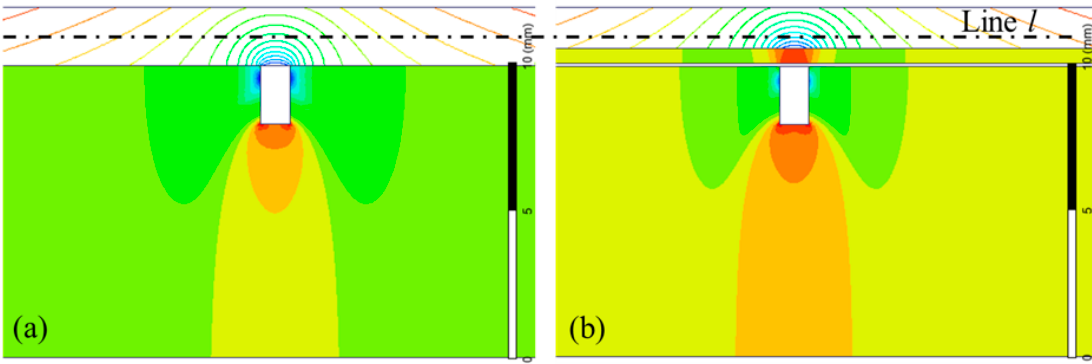
Figure 5. The MFL distribution. ( a ) The magnetic flux distribution with the NFMS; ( b ) the magnetic flux distribution affected by the FMS.